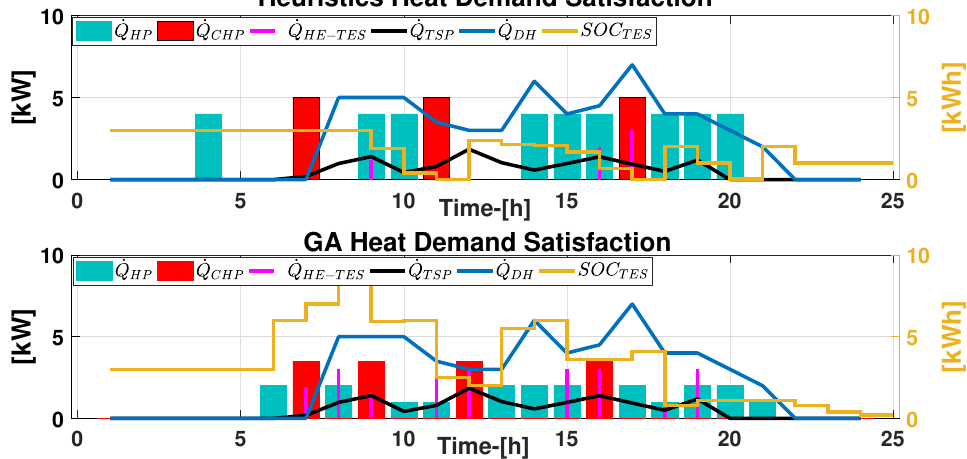
Figure 12. Heuristics and GA heat demand satisfaction numerical results for Example